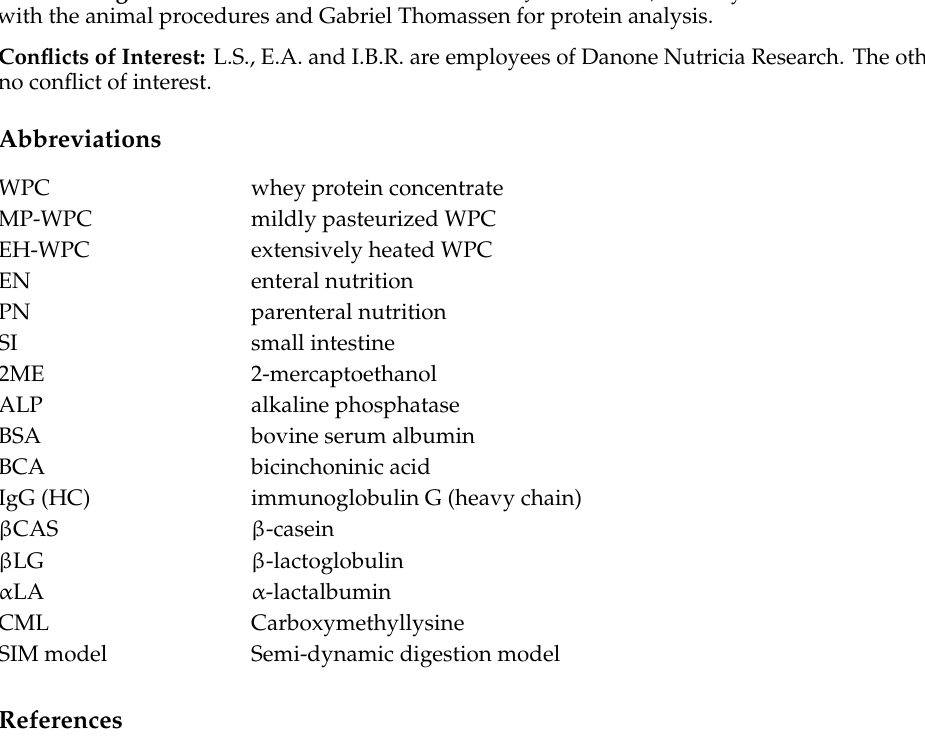
s1, Table S1: Enteral & parenteral nutrition, Table S2: Fecal assessment, Figure S1: Experimental set-up, Figure S2: Absorption, Figure S3: Gastric content, gastro-enterocolitis and colonic transit time, Figure S4: in vitro protein